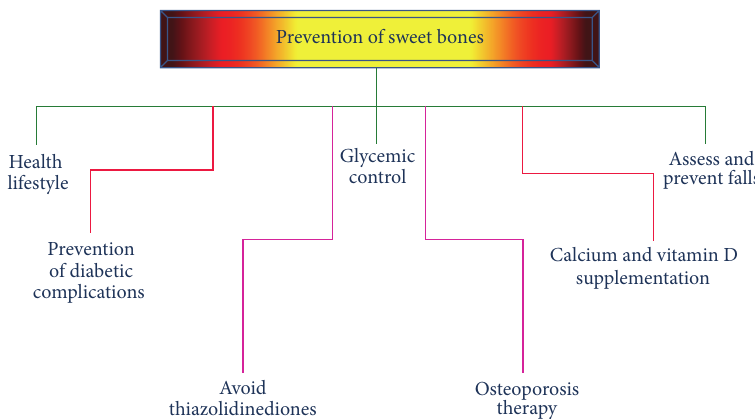
Figure 2: Preventive measures of sweet